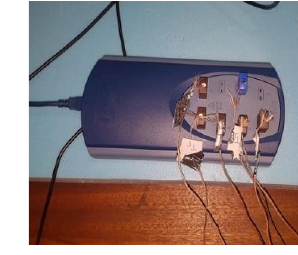
couples (Figure 3c).